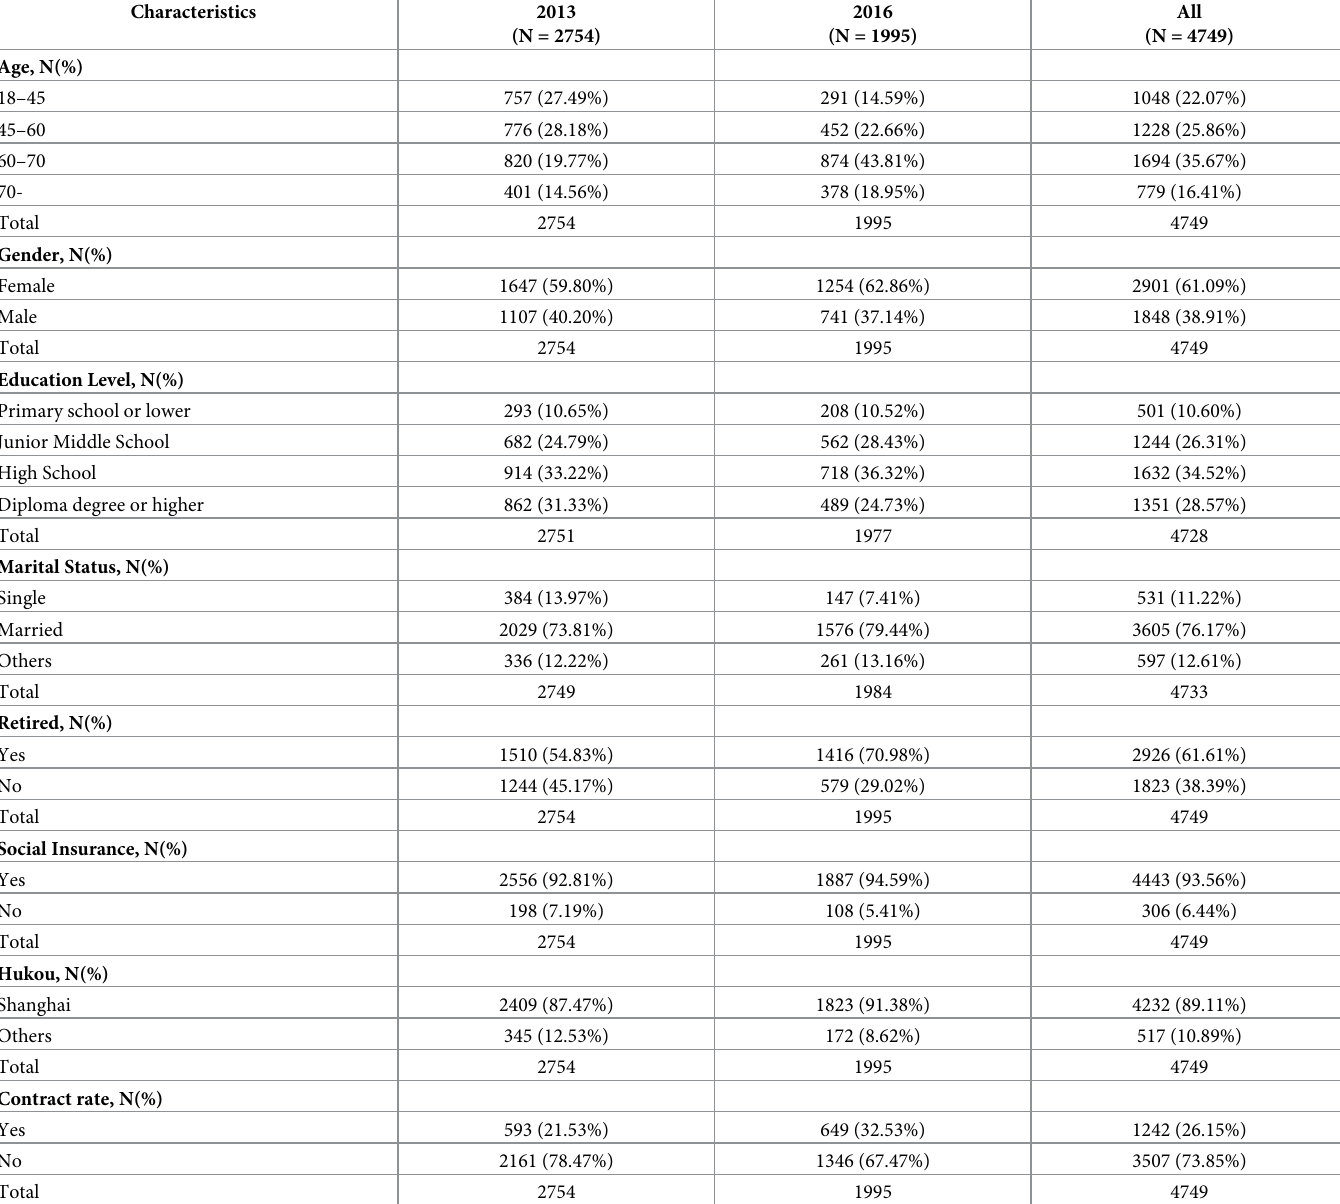
Table 1. Distribution of respondents’ sociodemographic characteristics,